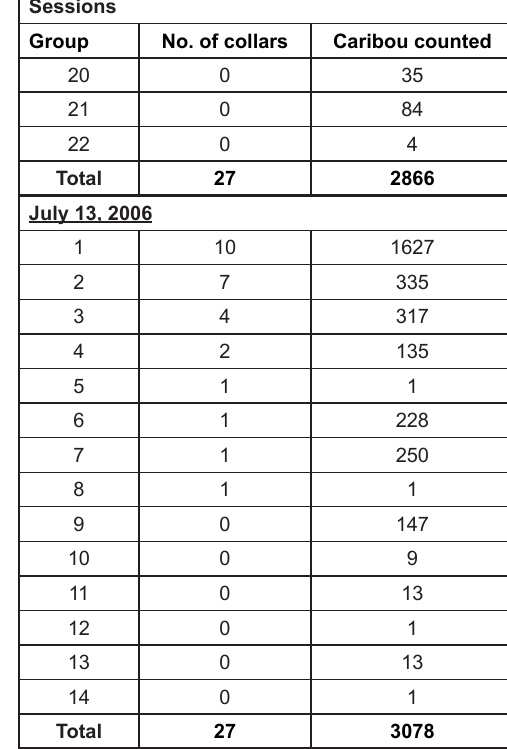
Table 36. Summary of sampling for the Tuktoyaktuk Peninsula Herd on two dates in July 2006.